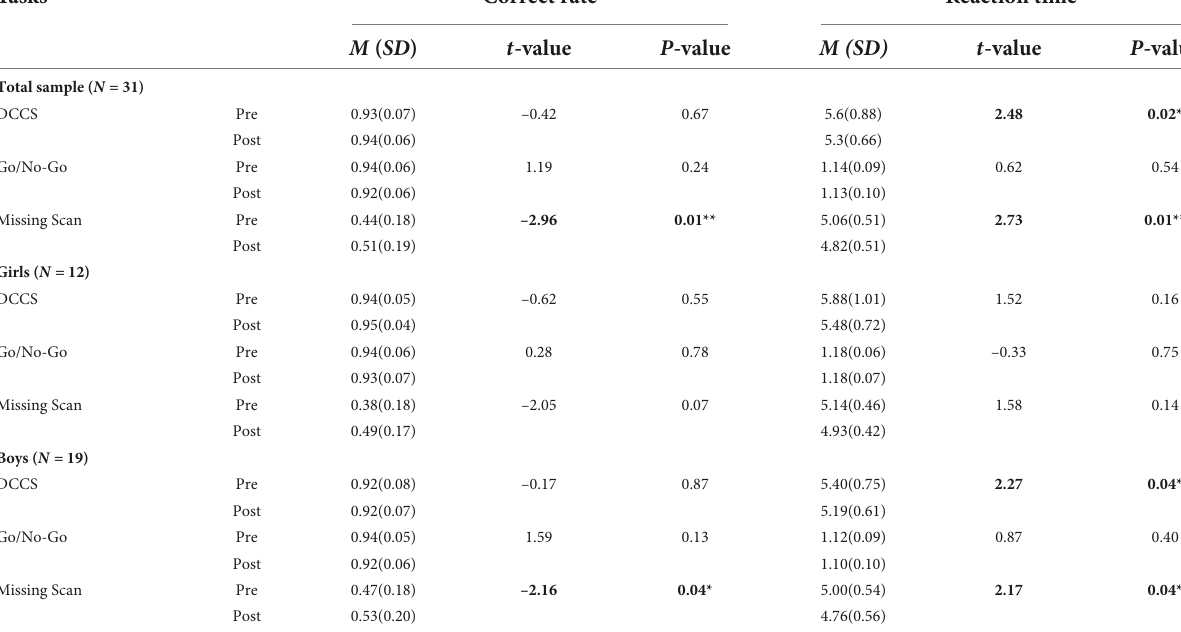
TABLE 1 Results for paired sample t -test of behavioral tasks before and after the intervention.